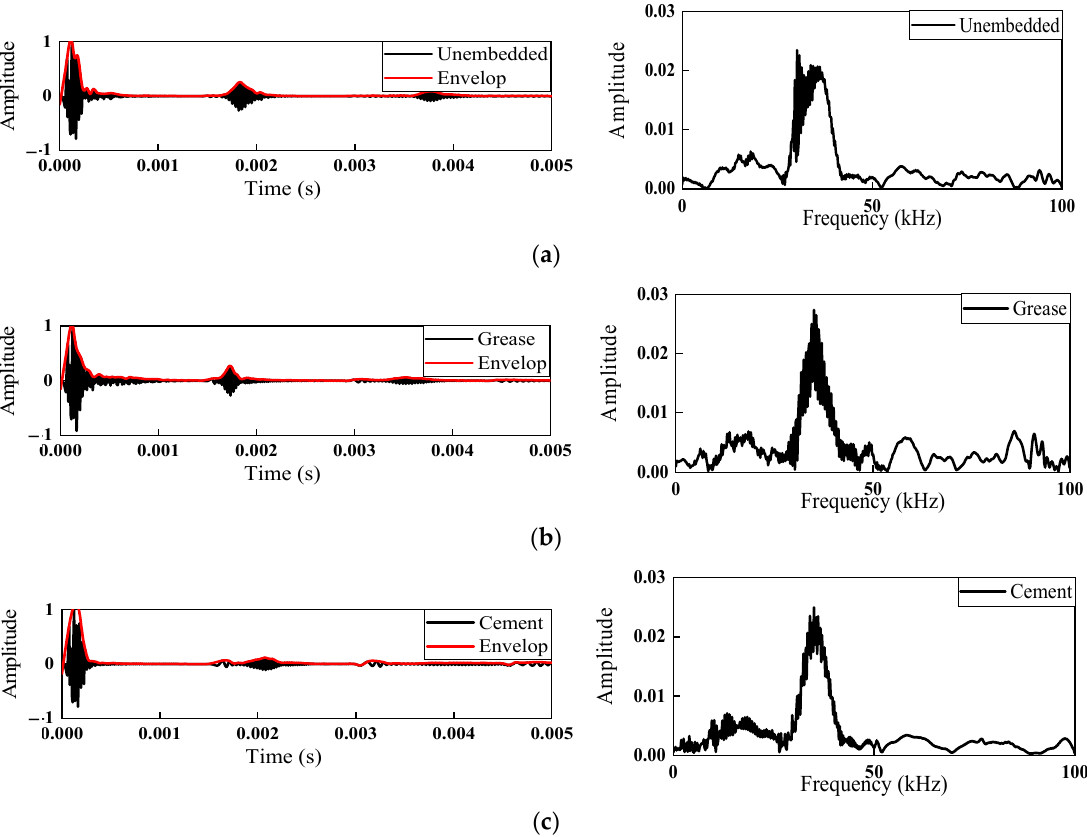
Figure 5. Received signals for rods with different grout methods: ( a ) no grout; ( b ) grease; ( c ) ce- ment.